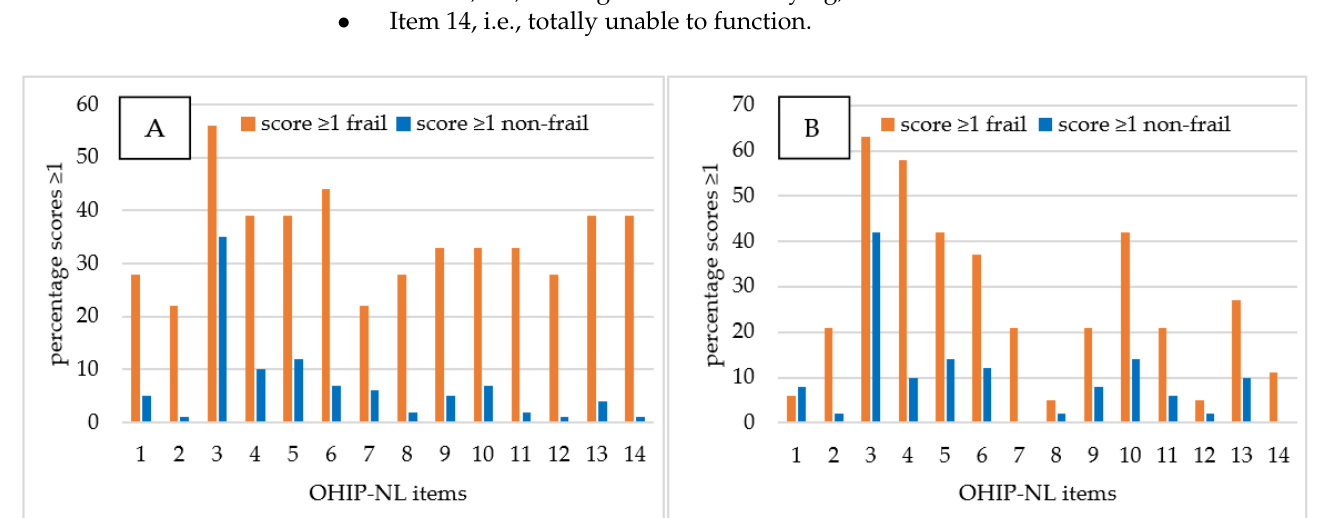
Figure 1. Percentages of OHIP-NL item scores ≥ 1 of frail ( n = 18) vs. non-frail ( n = 82) participants aged 55–64 years ( A ) and frail ( n = 19) vs. non-frail ( n = 51) participants aged ≥ 65 years ( B ).